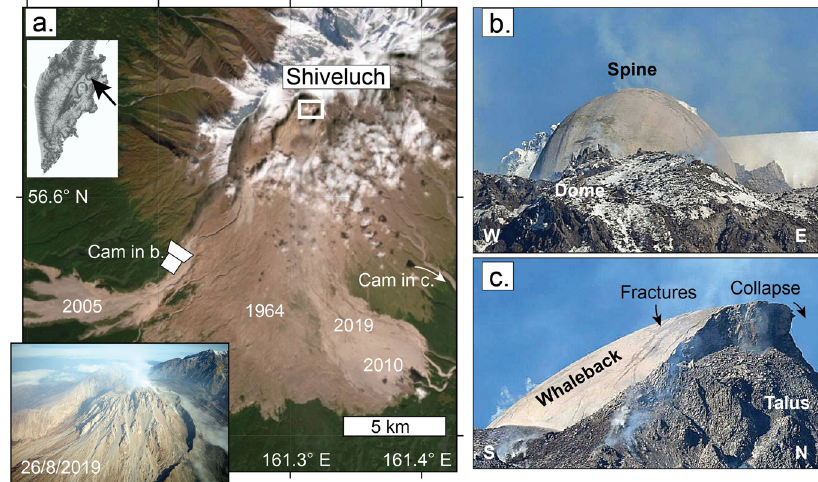
Fig. 1 Spine growth at the Shiveluch volcano. a Satellite and helicopter image illustrating the scale of the Shiveluch volcano, its horseshoe-shaped amphitheater, the 1964 debris avalanche, and the 2005, 2010 and 2019 pyroclastic density current deposits on the southern fl ank (years of deposition shown in fi gure). b , c Photos from the south (top) and from the southeast (bottom) showing the whaleback spine on September 28, 2020 (photos by Yury Demyanchuk, see a for camera (Cam) location). Note the sharp cliff and fractures on the northern side, as well as striations on the whaleback. The map in a was created using ArcMap vs. 10.8.1.